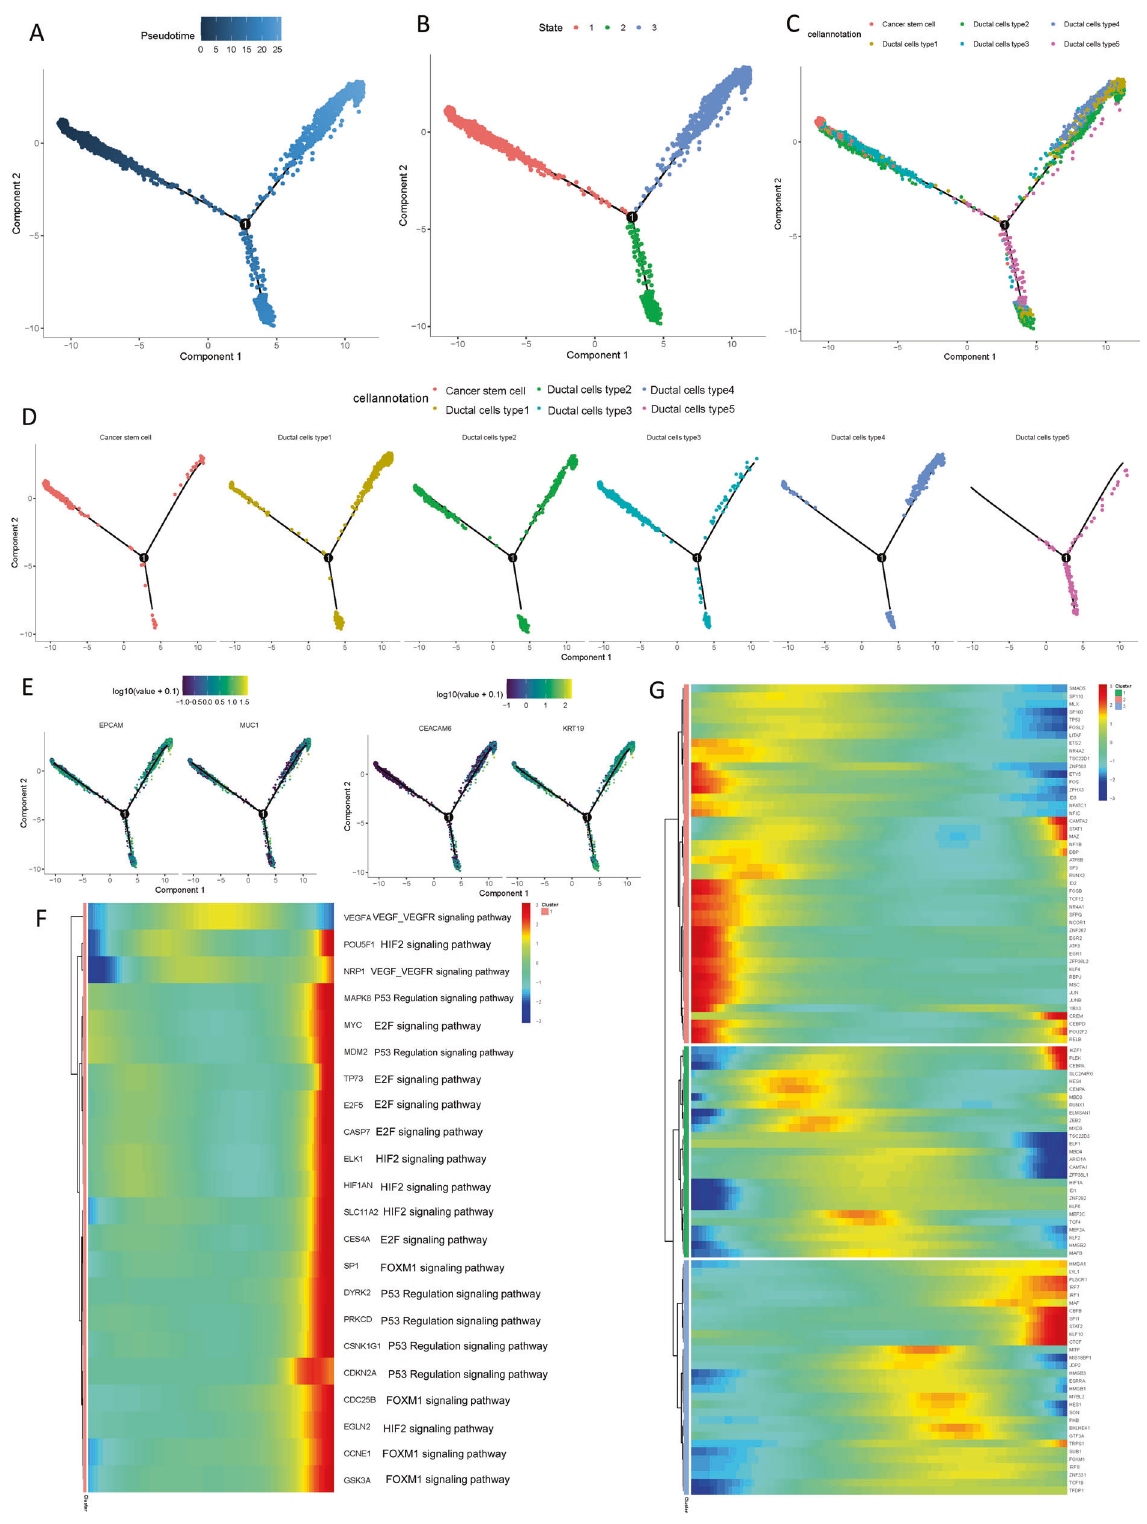
Fig. 4 Simulation of the development trajectory of malignant cells and the analysis of gene expression pattern inferred by Monocle2. Simulation of the differentiation trajectory of malignant cells group from PDAC, A pseudo-trajectory of malignant cells, B cell type transition, C cell source transition. D Pseudotime trajectory of malignant cells from different cells. Each point corresponds to a single cell. E Expression of representative genes (EPCAM, KRT19, MUC1, and CEACAM6) are mapped to the single-cell trajectory plot. Color key from gray to red indicates relative expression levels from low to high. F Heatmap showing expression of representative known PDAC associated genes across single cells. Corresponding pathways for each gene were also shown. Color key from blue to red indicates relative expression levels from low to high. G Heatmap showing expression of representative identi fi ed TFs across single cells. Color key from blue to red indicates relative expression levels from low to high. Cell Death Discovery (2021)